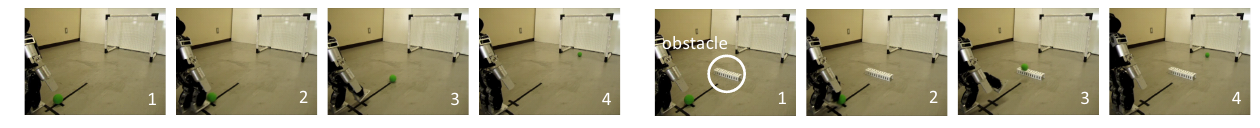
Figure 10. Experimental scenes of base motion by the HOAP-3